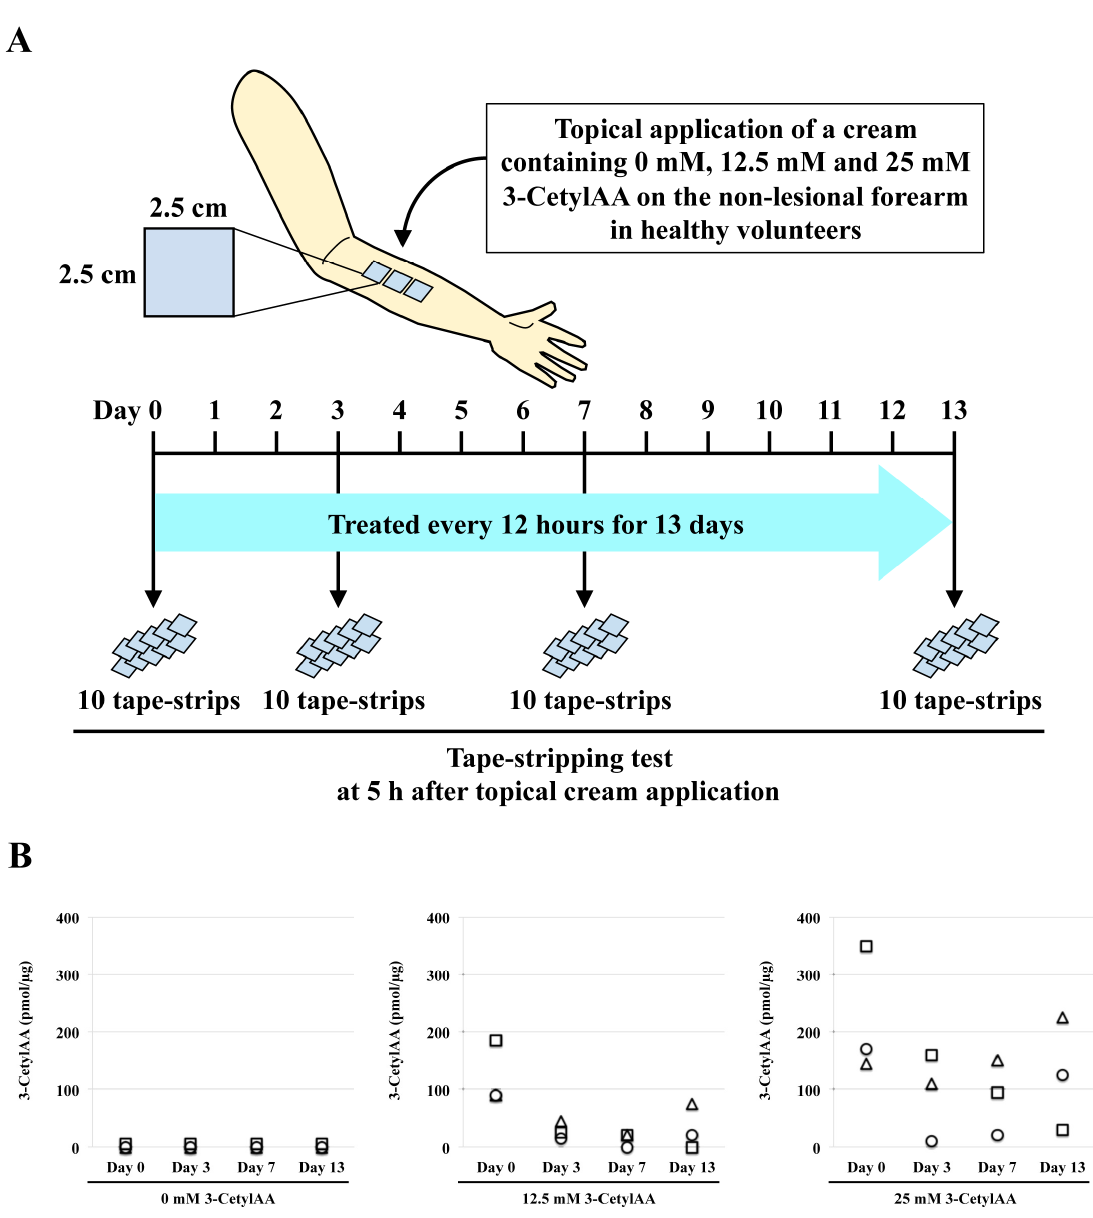
Figure 1. Amounts of 3-CetylAA in the stratum corneum after a 5-h uptake: ( A ) Study design and treatment schedule. A cream containing 0 mM, 12.5 mM, and 25 mM 3-CetylAA was topically applied to the ventral side of the non-lesional forearm in three healthy volunteers. All volunteers underwent twice-daily treatments for 13 days. At the indicated time points, ten serial tape-strips (2.5 cm × 2.5 cm) were obtained. ( B ) Quantification of 3-CetylAA in the stratum corneum. The amounts of 3-Cetyl AA were quantified in the first ten strips from the three volunteers by high-performance liquid chromatography analysis, and they are indicated as the total amount of ten tapes in each